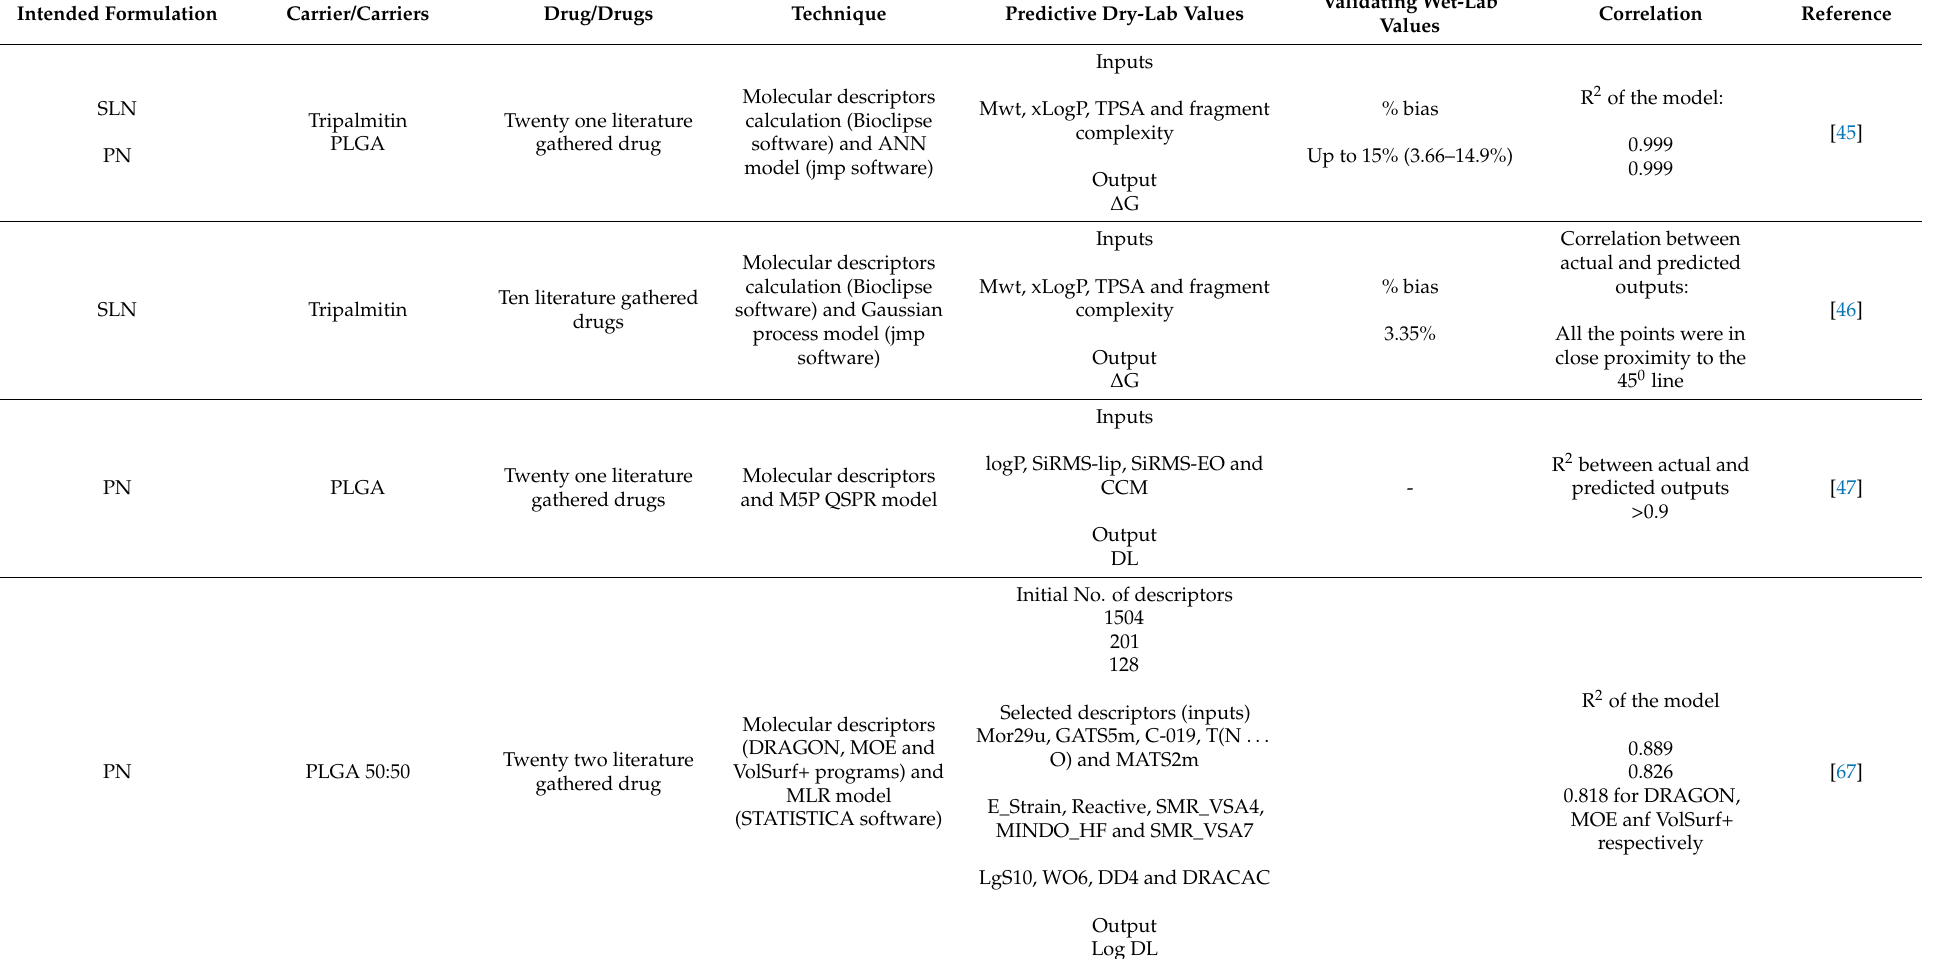
Table 6. Different applications of machine learning techniques for modelling lipid and polymeric